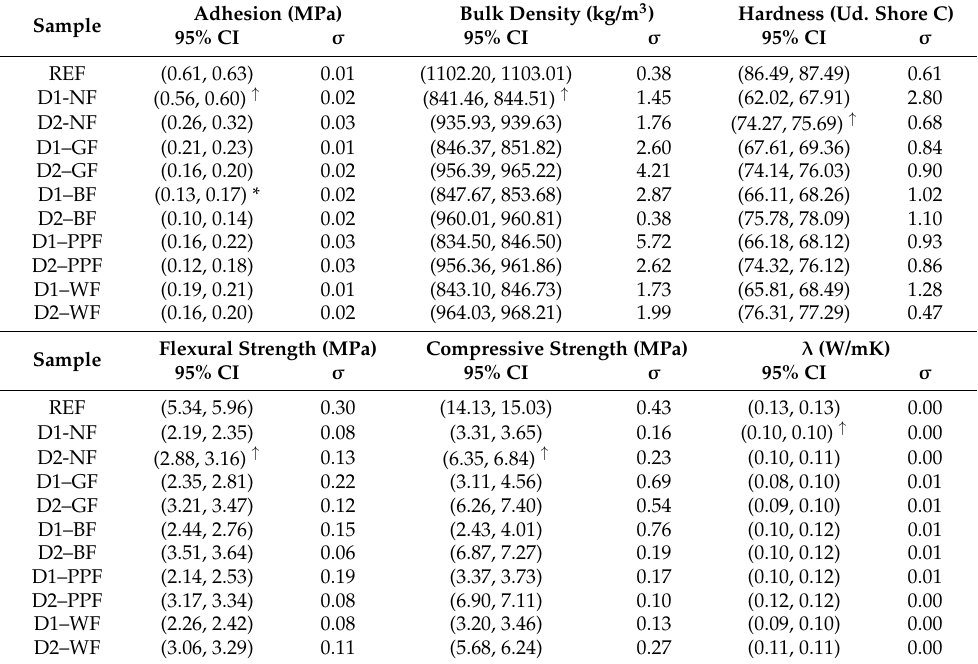
Table 8. Confidence intervals and standard deviation ( σ ) for the mean for each dosage and